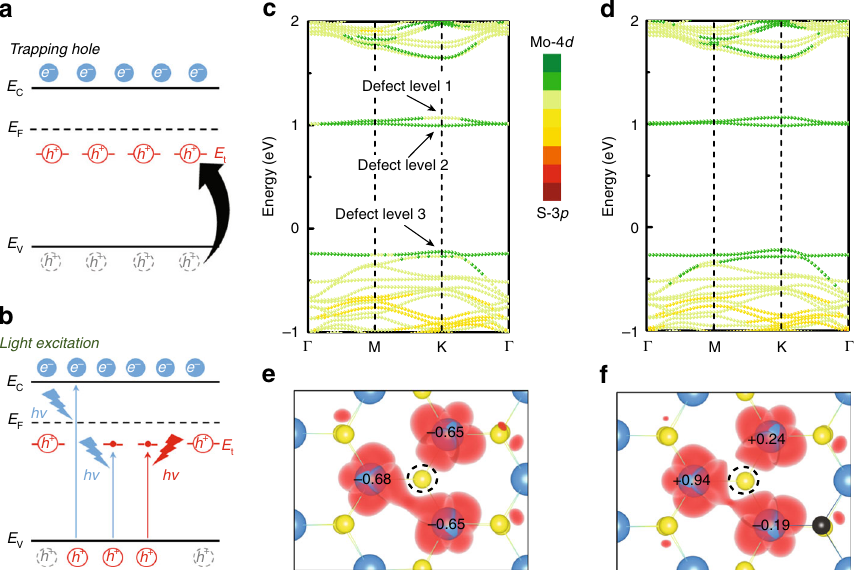
Fig. 1 Physical model of carrier trapping. a , b Schematic band diagrams of deep traps ( E t ) in a typical n-type semiconductor. Under non-equilibrium conditions, excess minority carriers (holes) will be captured and stored in E t ( a ). These trapped holes can be released through recombining with the light- excited electrons from valence band ( b ). Electrons and holes are represented by blue and red circles with e − and h + , respectively. Gray circles with h + are the disappeared holes. E C , E V , and E F indicate the conduction band edge, valence band edge and Fermi level, respectively. c , d Projected band structure of defective (with a single S vacancy) monolayer 2H-MoS 2 without ( c ) and with ( d ) a substitutional Se atom (corresponding Se concentration is 3.13%). Fermi level is set to zero. e , f Bader charge value (in unit of |e|) and wave function of defect levels in defective (with a single S vacancy) monolayer 2H- MoS 2 without ( e ) and with ( f ) a substitutional Se atom. Mo, S, and Se atoms are represented by blue, yellow, and black balls, respectively. S vacancy is marked by black dotted circle. The Bader charge value from negative to positive means that the ability to lose (obtain) electrons is gradually weakened (enhanced). The isosuface value of wave function is 0.1 eÅ − 3 . Source data are provided as a Source Data fi